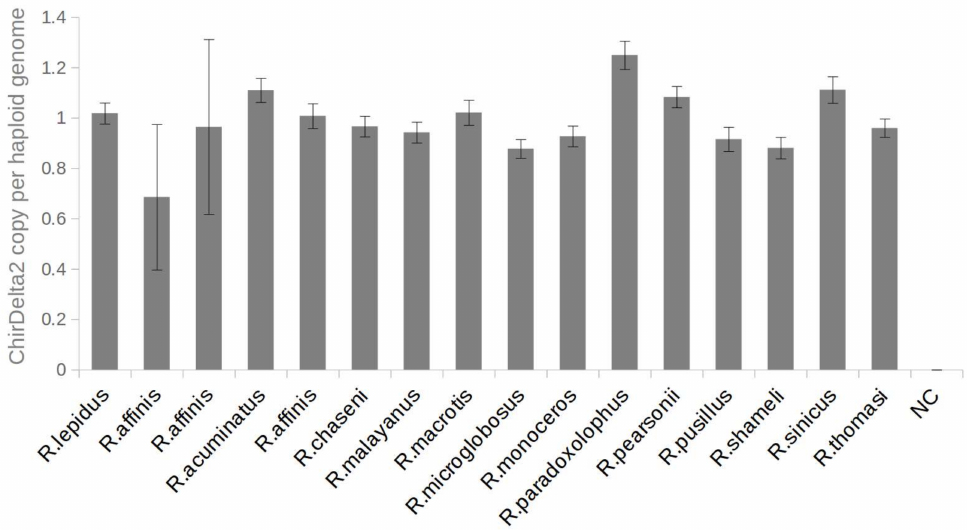
Figure 3. Number of ChirDelta2 copies in genomes of rhinolophid species. The chart shows copy numbers of ChirDelta2 sequence. These were determined by ddPCR absolute quantification using a set of primers specific to the internal part of the ChirDelta2 sequence. All values were normalized to the values obtained for reference locus in rhinolophid genome. The error bars represent poisson 95% confidence intervals of ddPCR analysis. NC—nontemplate